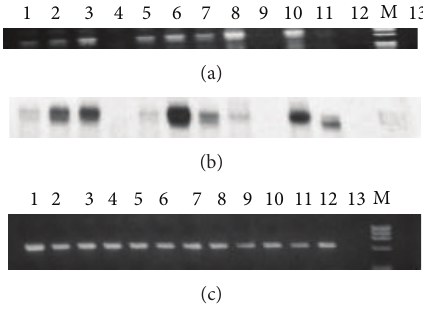
Figure 4: Expression of TPM1B transcripts in breast epithelial cell lines. cDNA from each cell line was amplified with the TPM1. Exon 1a(+)/TPM1. Exon 9d( − ) primer pair (Table 1). Amplified DNAs were run on an agarose gel (Panel (a)) and subsequent hybridiza- oligonucleotide probe (Panel (b)). Panel (c) depicts the ethidium bromide staining of the DNA amplified from human GAPDH